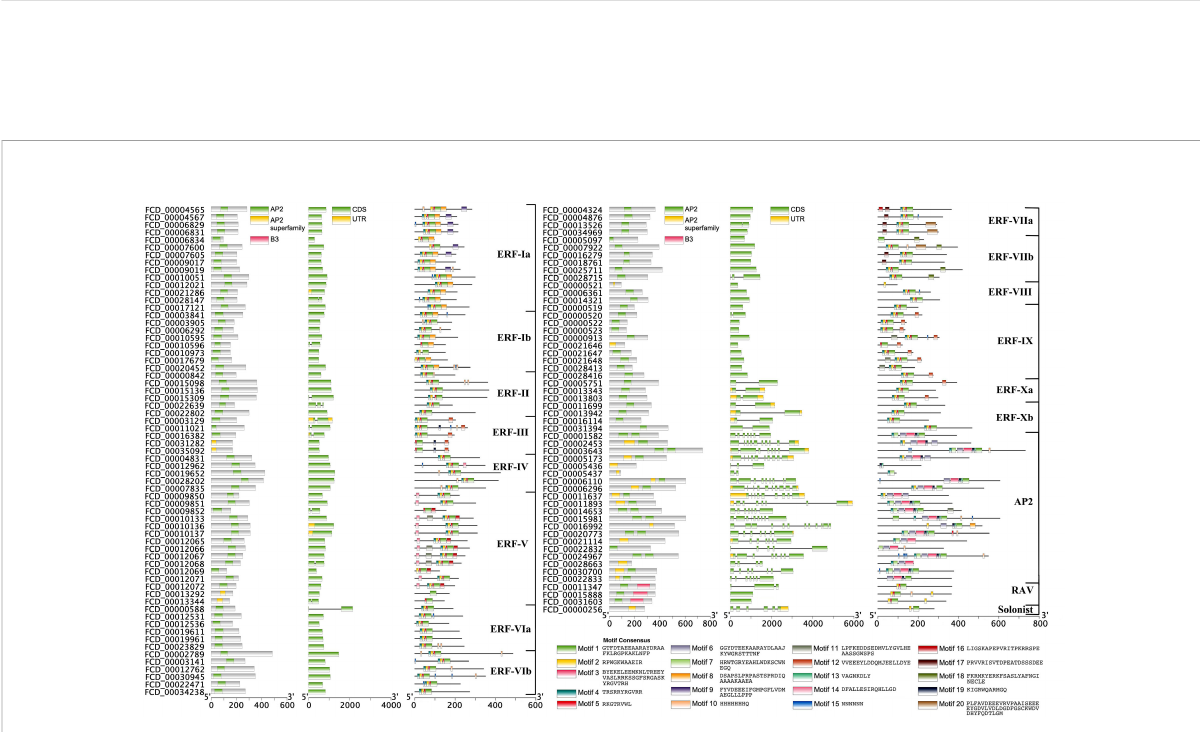
FIGURE 3 Analyses of domains (left), gene structure (middle), and motifs (right) in F. carica